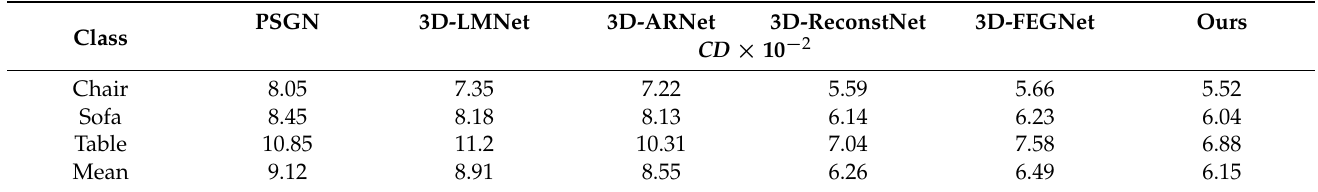
Table 6. Reconstruction results on Pix3D evaluated by CD.